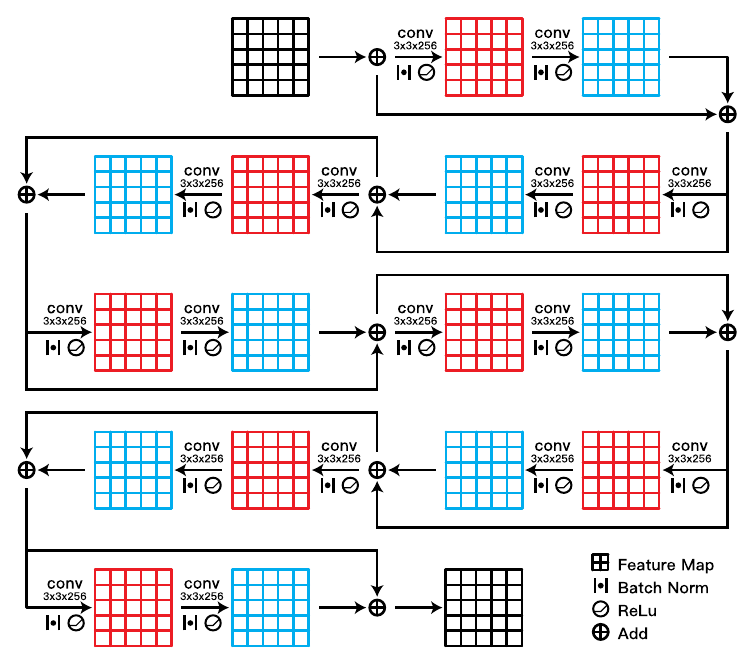
Figure 3. The Res-net block structure between encoding and decoding.